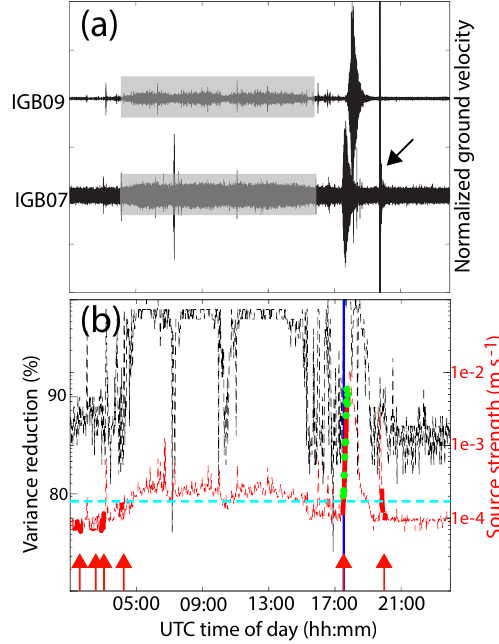
Figure 9. Results of the ASL approach. (a) Seismograms of sta- tions IGB07 (in the Illgraben catchment) and IGB09 (in the Rhône Valley). Black arrow indicates high-frequency arrivals of the M 6.2 2011 Fergana Valley earthquake in Kyrgyzstan. Grey boxes high- light increased amplitudes due to anthropogenic noise. (b) Variance reduction (black) and equivalent source strength (red). Thick solid red lines denote time instances when the best-fit location lies in the Illgraben catchment (also indicated with red arrows); dashed lines denote the remaining time instances. Green dots represent times when three detection criteria were satisfied: (1) location in upper catchment, (2) variance reduction above 90% and (3) source strength A 0 above 1.7 × 10 − 4 ms − 1 . The blue vertical line marks 17:32, which we propose as the initial detection time of the debris flow.